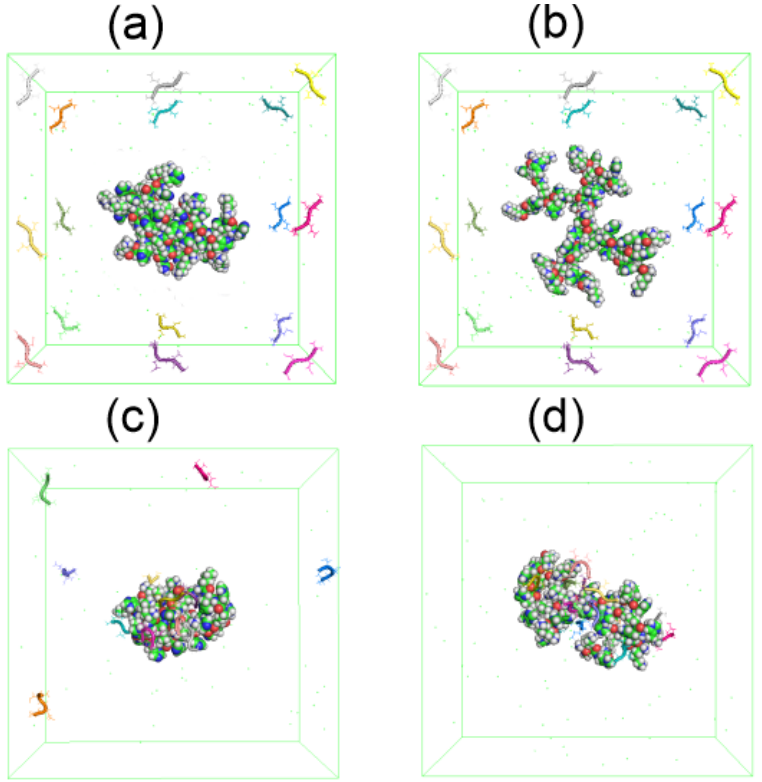
Figure 14. The snapshots of Lys–2His or Lys–2Hisp dendrimers and 16 AEDG peptides before the complex formation: ( a ) Lys2His + 16AEDG and ( b ) Lys2Hisp + 16AEDG, and after the complex formation: ( c ) Lys2His + 16AEDG and ( d ) Lys2Hisp + 16AEDG.